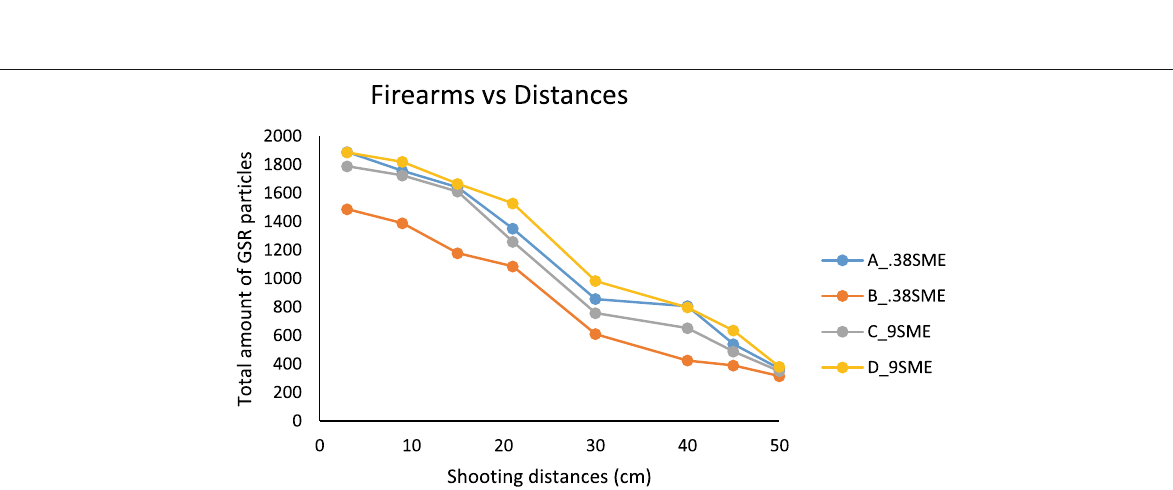
Fig. 5 Total amount of GSR particles from different types of firearms vs. shooting distance